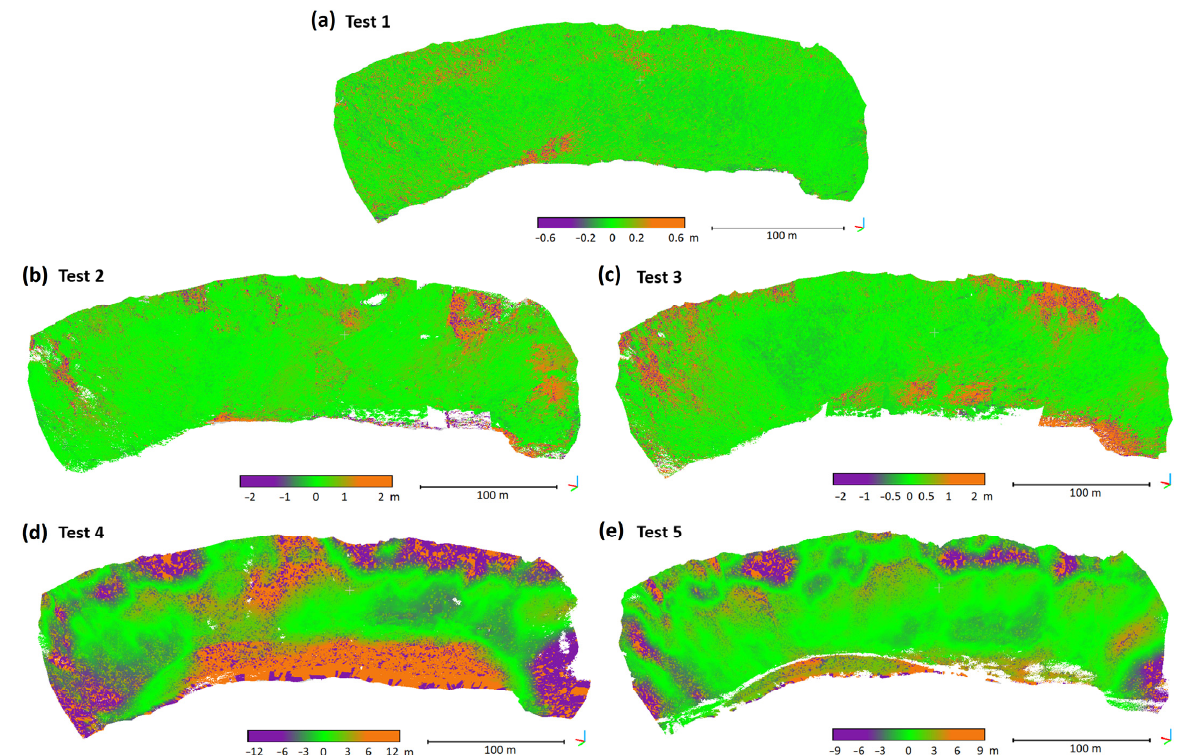
Figure 7. Spatial distribution of the cloud-to-mesh distances between the mesh resulting from the “expert dataset” (used as reference) and the different scenarios testing the incorporation of crowd- sourced photographs (illustrations ( a – e ) corresponding, respectively, to Tests 1 to 5). Note: The color scale varies between the different tests.